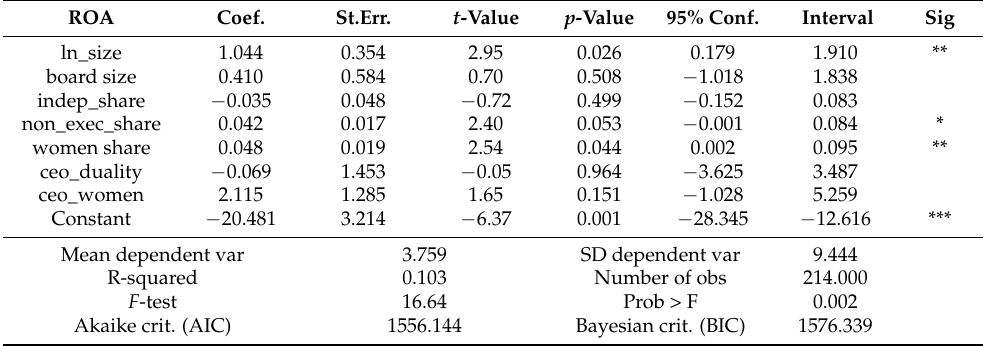
Table A3. Regression Model for ROA.